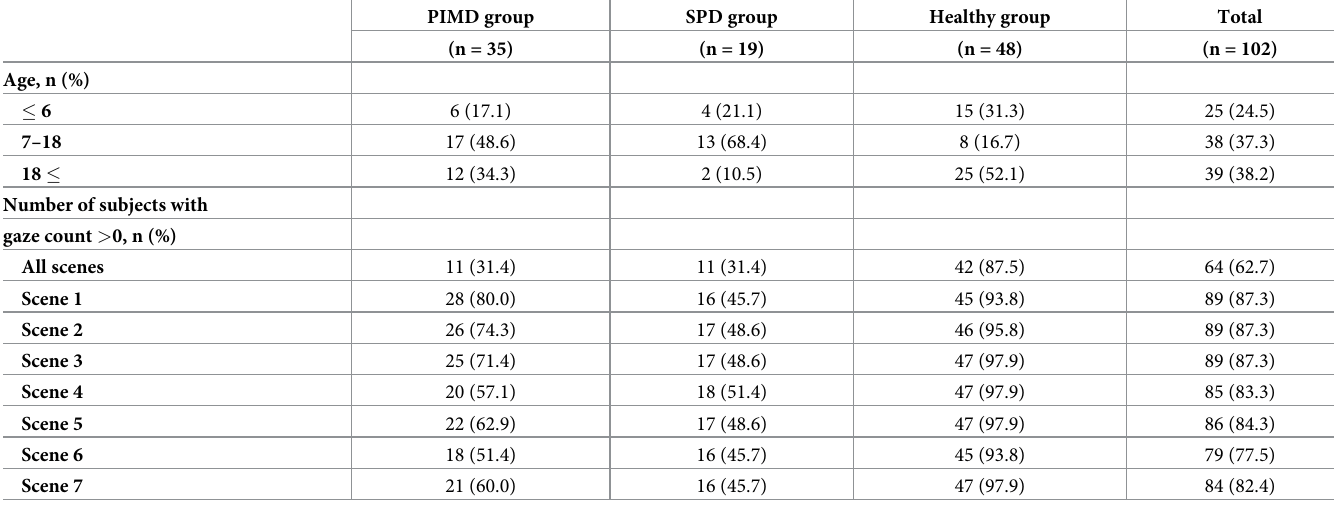
Table 1. Characteristics of study subjects and subjects with gaze count > 0 for each scene.